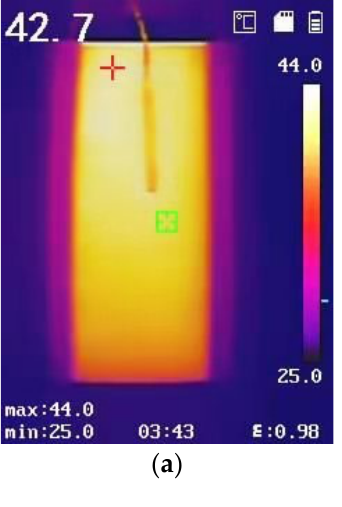
Figure 4. ( a ) Infrared thermal image of graphene heating at 42 ◦ C; ( b ) Far-infrared emission spectra of graphene heating device at different temperatures.